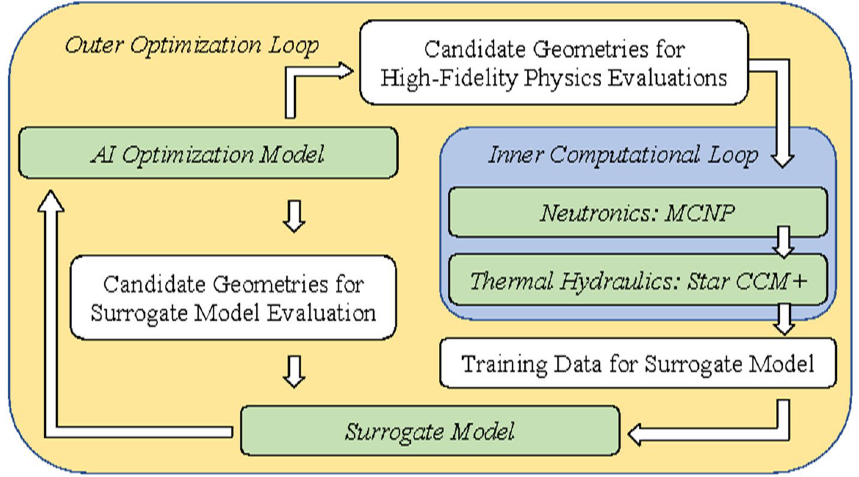
Figure 2. Illustration of the AI optimization workflow. Created using Microsoft PowerPoint, version 16.52, www. micro soft.